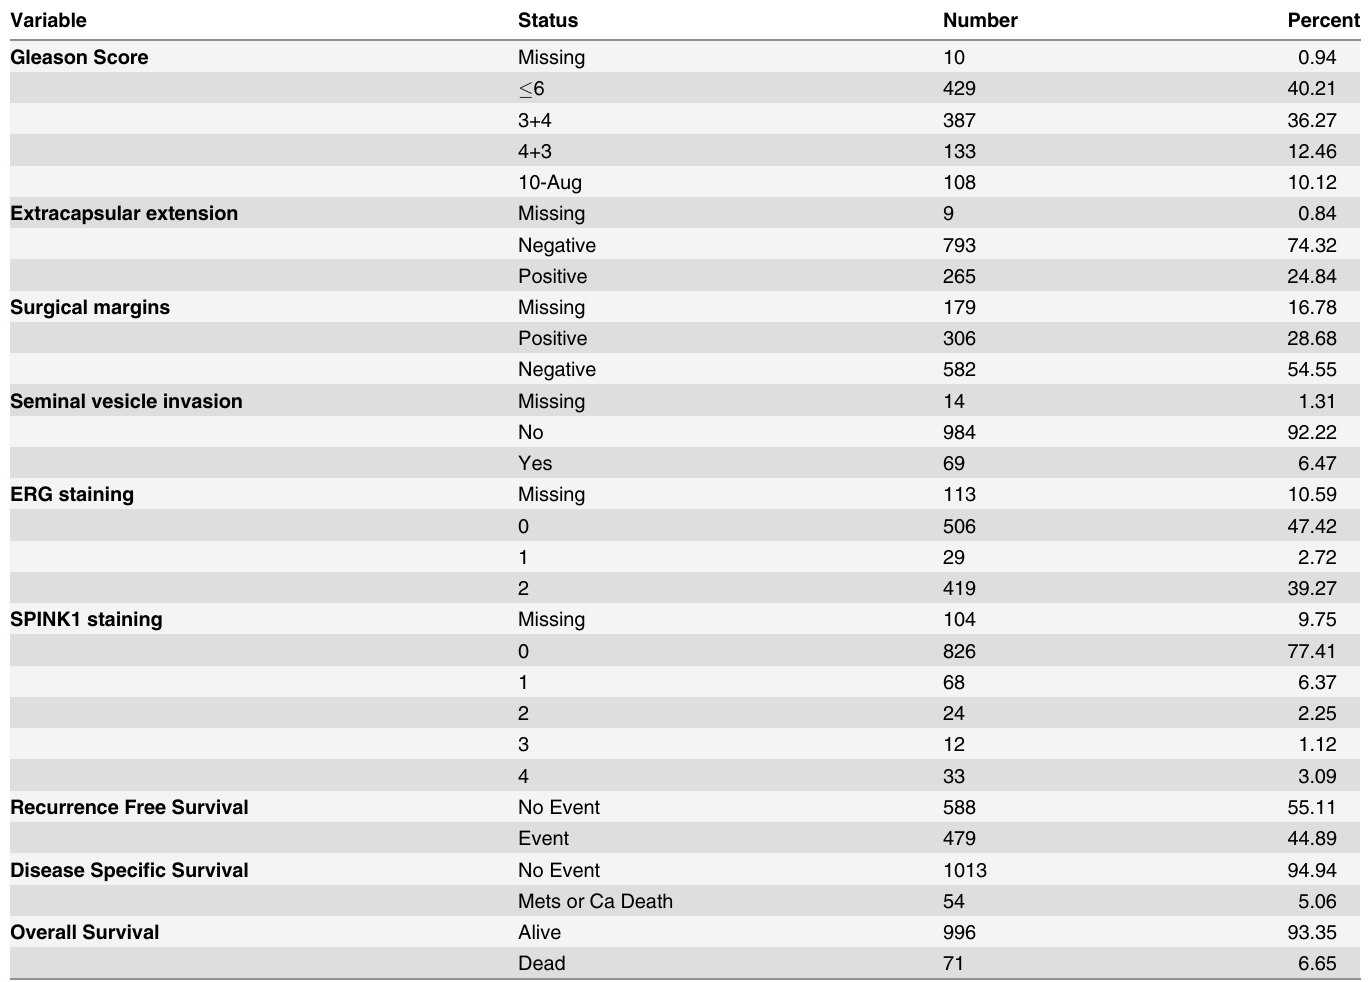
Table 1. Summary of clinical, pathological and staining